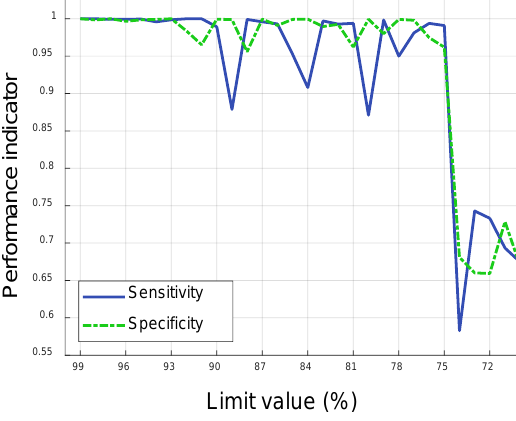
Figure 9. Trends of sensitivity and specificity depending on limit value in fault detection.